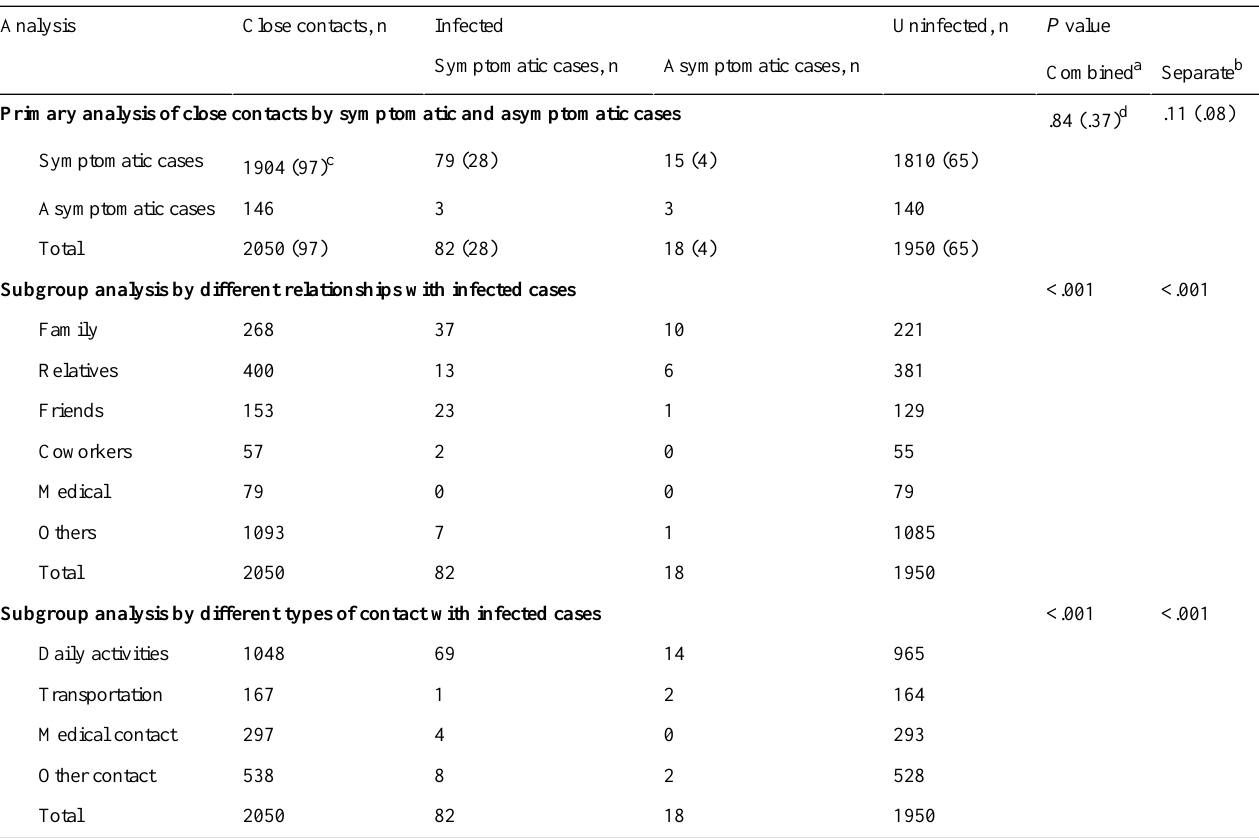
Table 3. Primary analysis with the estimated rates and 95% CIs.